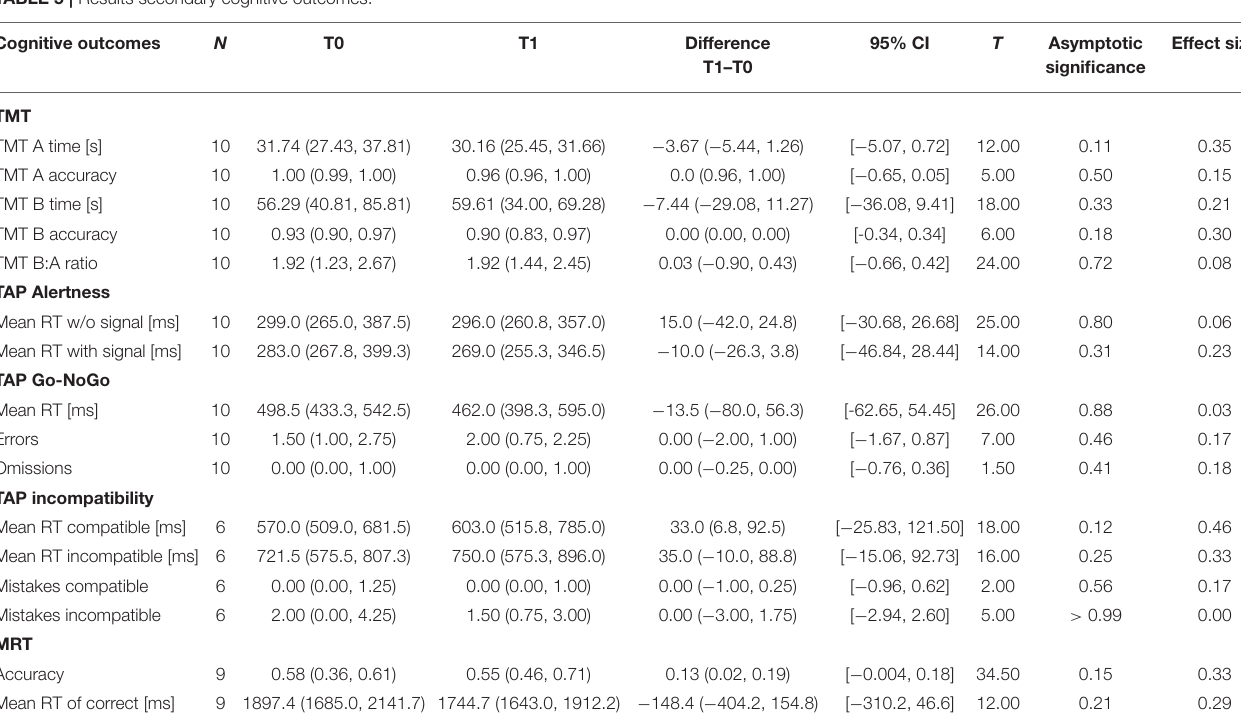
TABLE 5 | Results secondary cognitive